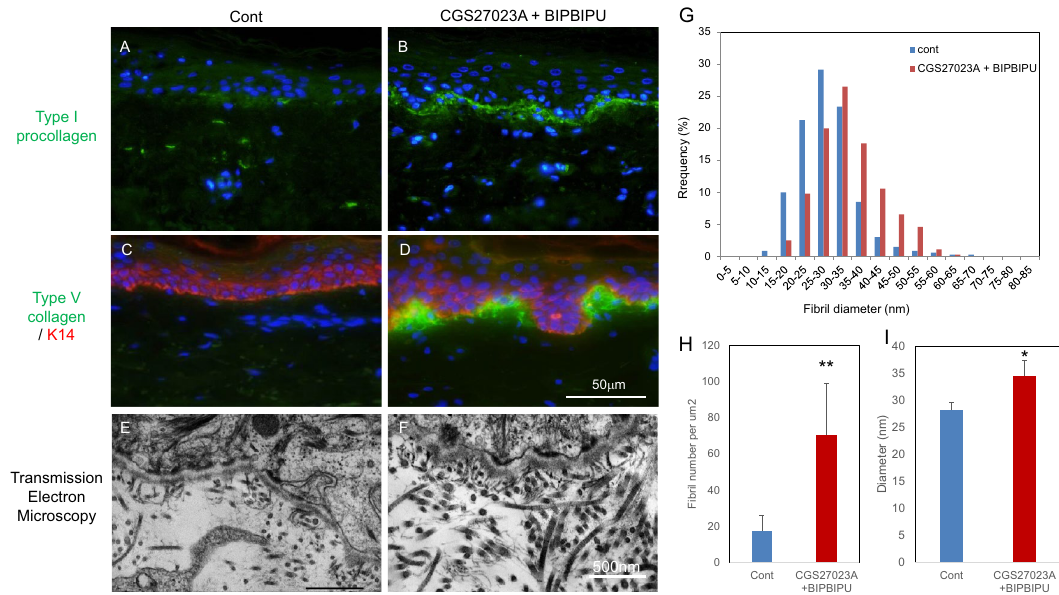
Figure 2. The effect of MMP inhibitor and heparinase inhibitor on the accumulation of collagen fibrils in the organotypic human skin model. Immunostaining of type I procollagen ( A, B ) and type V collagen ( C, D ), and transmission electron microscopy images ( E, F ) of organotypic human skin model in the presence of MMP inhibitor CGS27023A and heparinase inhibitor BIPBIPU ( B, D, F ) as compared with the control ( A, C, E ). The distribution ( G ), density ( H ) and diameter ( I ) of collagen fibrils were analyzed by WINROOF 2015. White bars in D : 50 μm. White bar in F : 500 nm. Data are expressed as mean ± SD of three independent experiments using samples from six donors. * p < 0.05, ** p <